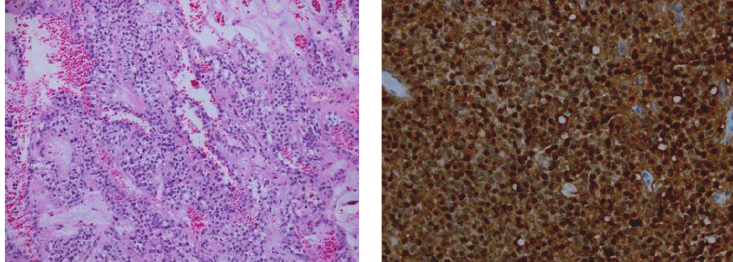
Figure 2: Pathology of solid pseudopapillary tumor of the pancreas H and E stain and B-catenin stain with the prominent nuclear